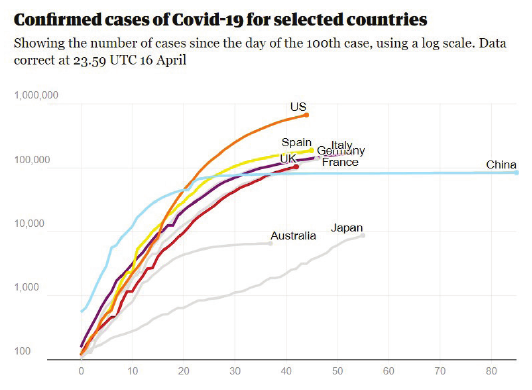
Figure 1. Confirmed cases of COVID-19 in selected countries source Johns Hopkins CSSE